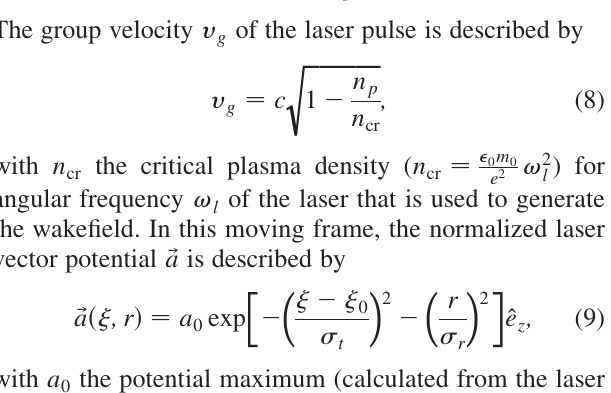
ffiffiffiffiffiffiffiffiffiffiffiffiffiffiffi